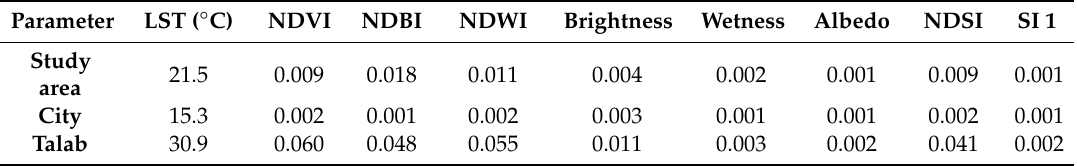
Table 3. The mean surface biophysical characteristics variance values for the Gomishan wetland, Gomishan city, and study area between 1987 and 2017.